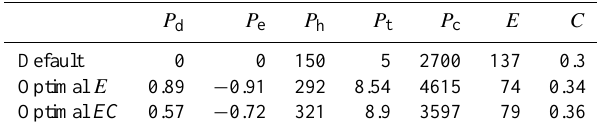
Table 2. The values of five identified parameters in the KF scheme, skill scores E and C , used or obtained in the simulations with de- fault or optimized (based on E or EC , respectively)